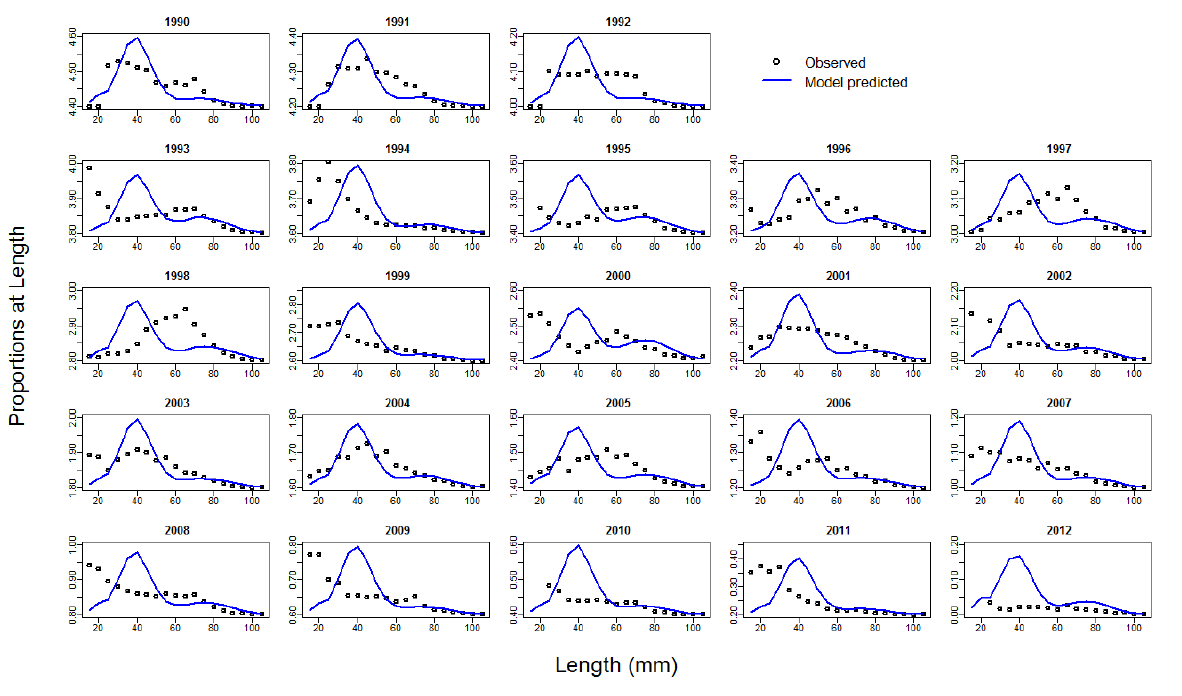
Figure A2.5. Comparison of model predicted length proportions of oysters 15-105 mm in size from Apalachicola Bay, Florida during fall (blue line) and observed length proportions of legal size oysters (black circles) from fisheries independent surveys conducted in fall by the Florida Department of Agriculture and Consumer